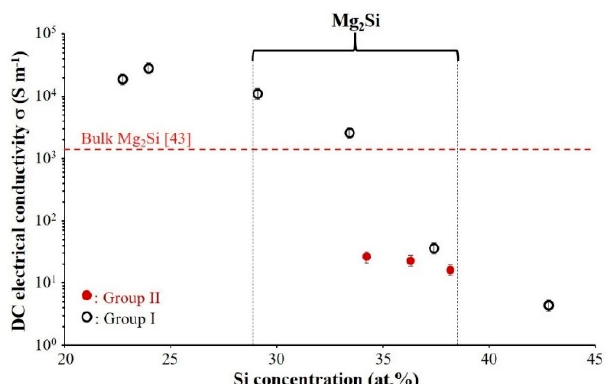
Figure 10. Room temperature electrical conductivity of Mg–Si thin films deposited on glass substrate vs. Si atomic concentration. (Selected zone indicates room temperature electrical conductivity of coatings with the composition closed to Mg 2 Si). (Group I: R P < 7 × 10 − 4 Pa and Group II: R P ≥ 7 × 10 − 4 Pa). The Seebeck coefficient of Mg–Si thin films measured at room temperature as a function of Si content is shown in Figure 11. All Seebeck coefficients are negative, as expected for n-type semiconductors. Except for the film with 37 at.% Si ( − 163 µ V K − 1 Seebeck value), no matter their Hatched zone indicates Mg 2 Si structure (29 ≤ at.% Si ≤ 38) and we believed the reason of high Seebeck value measured especially for the sample with 37 at.% Si in Group I should be related to the coexistence of amorphous and crystallized Mg 2 Si phases.